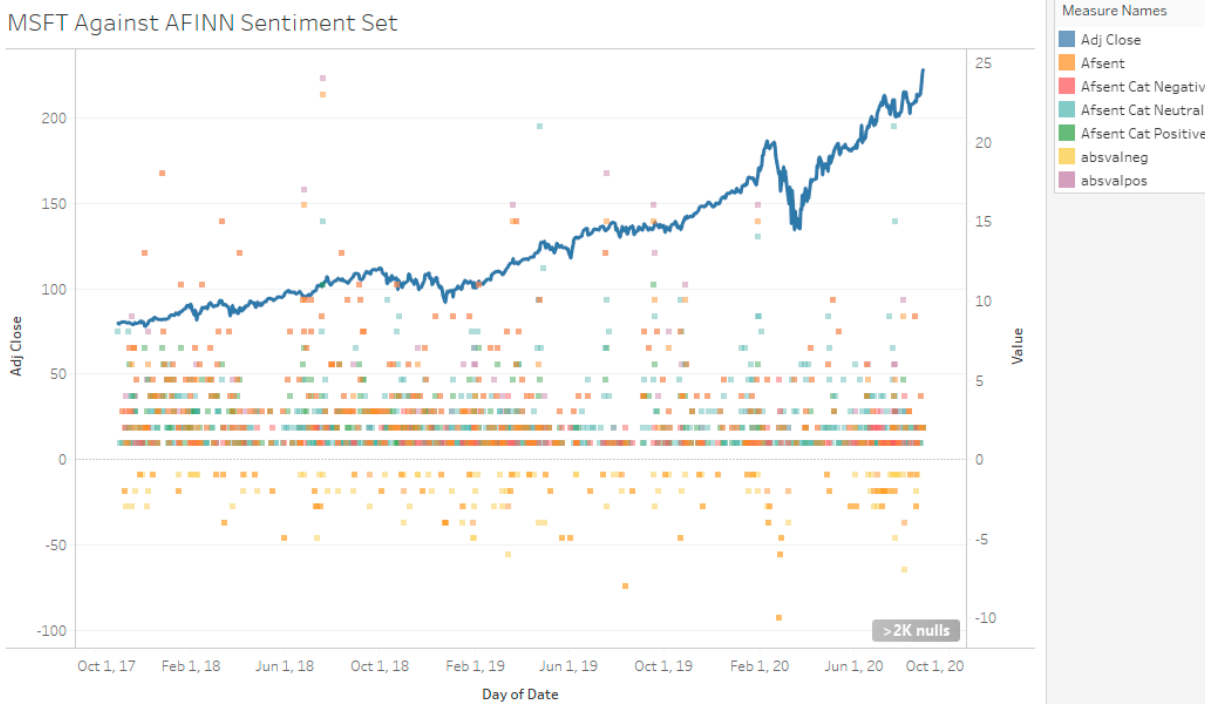
Figure 8. AAPL Stock Against AFINN Sentiment. 5.3.2. NRC Sentiment The NRC lexicon can attribute words to human emotions and to sentiment polarity. However, the negative and positive sentiment identification is more than AFINN (see